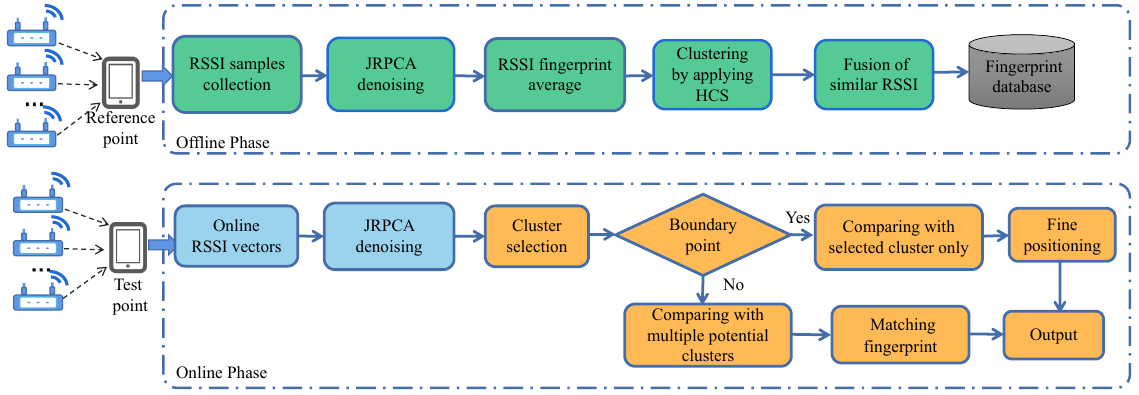
Figure 1. Framework of proposed fingerprint positioning